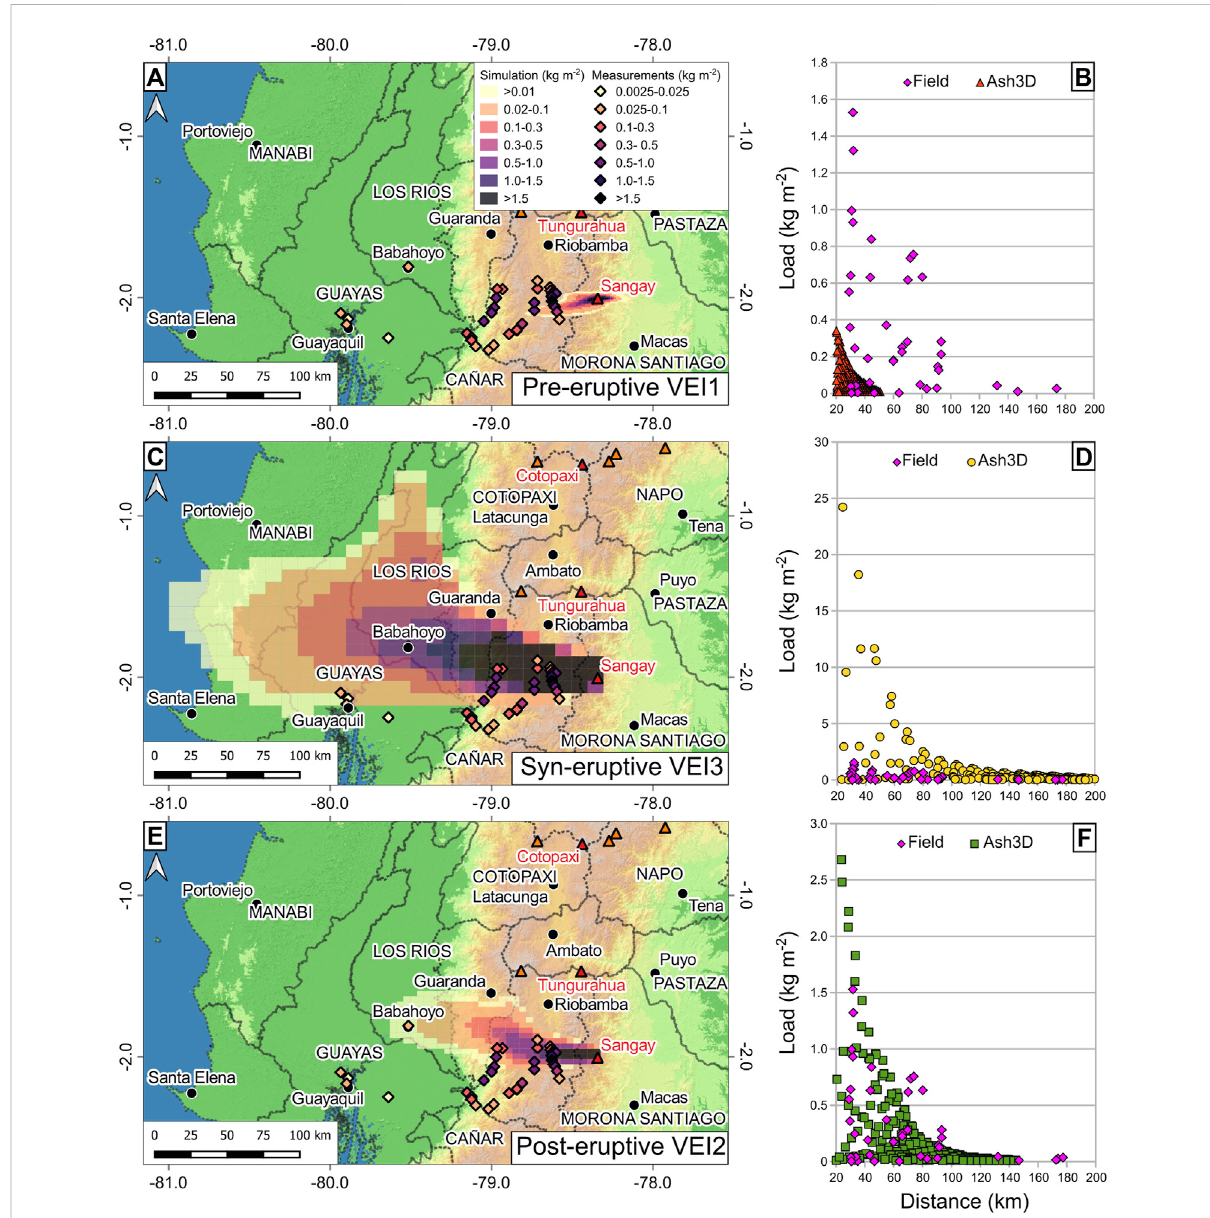
FIGURE 12 Comparison betweentheresultsoftheAsh3Dsimulationsandthe fi elddata. (A) mapand (B) bivariatediagram(distancefromthevolcanoinkm versus load in kg m − 2 ) comparing the results of the pre-eruptive (VEI 1) scenario simulation to the fi eld results; (C) map and (D) bivariate diagram for the syn-eruptive (VEI 3) scenario; (E) map and (F) bivariate diagram for the post-eruptive (VEI 2)